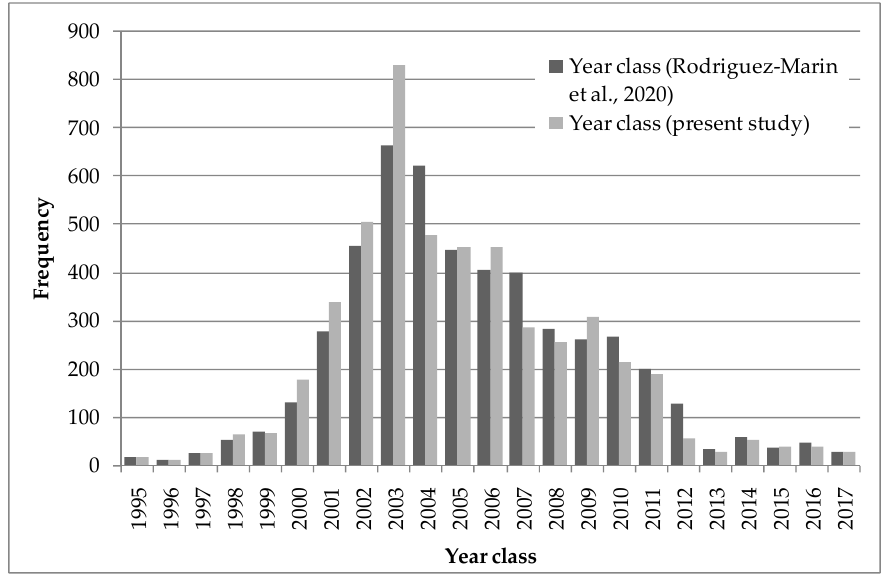
Figure 10. Number of Atlantic bluefin tuna by year class by applying the current [11] and present study age adjustment criteria to otolith band counts.